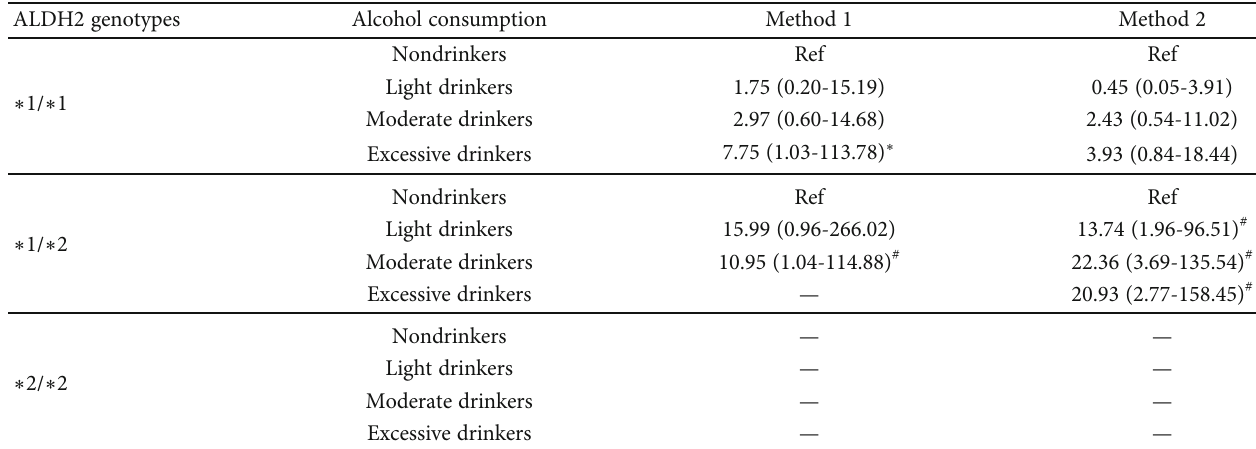
a Models were adjusted for age, gender, education, and subtype. ∗ p < 0 : 05 vs. nondrinkers with ALDH2 wild-type genotype ( ALDH2 ∗ 1/ ∗ 1 ). # p < 0 : 05 vs. nondrinkers with ALDH2 mutant genotype ( ALDH2 ∗ 1/ ∗ 2